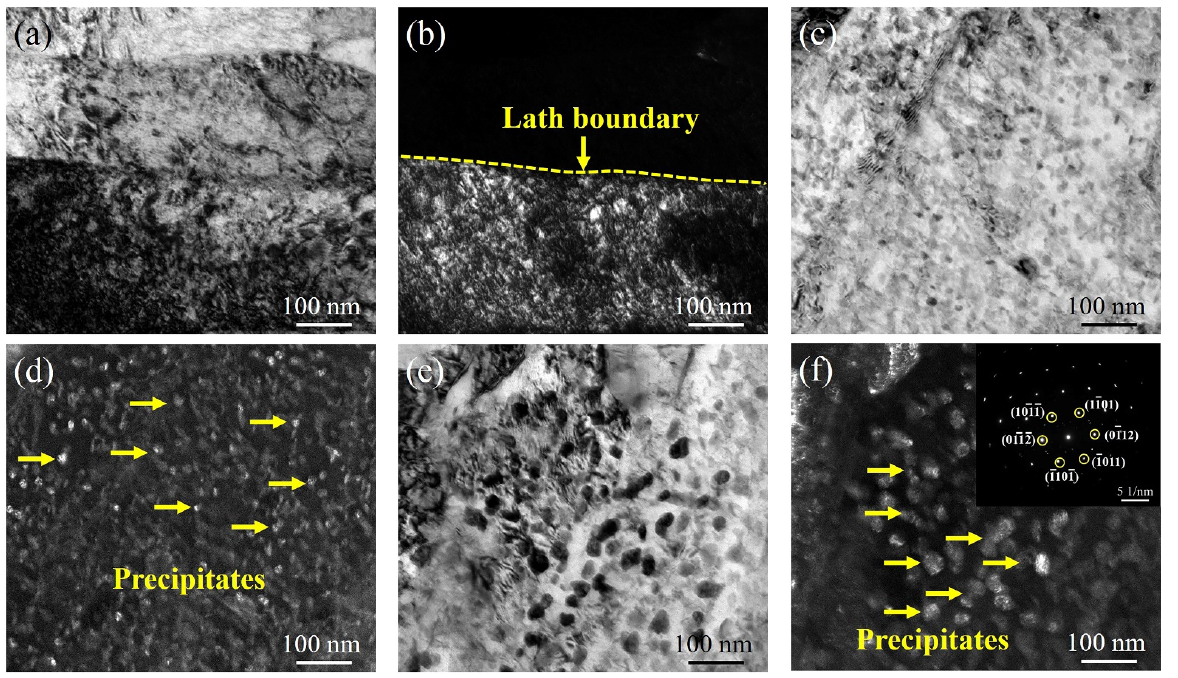
Figure 4. TEM morphology of the specimens under various thermal conditions: ( a ) bright-field image of 540A-0.5, ( b ) dark-field image of 540A-0.5, ( c ) bright-field image of 540A-4, ( d ) dark-field image of 540A-4, ( e ) bright-field image of 540A-80, ( f ) dark-field image of 540A-80 and the diffraction spot calibration results of the precipitates.